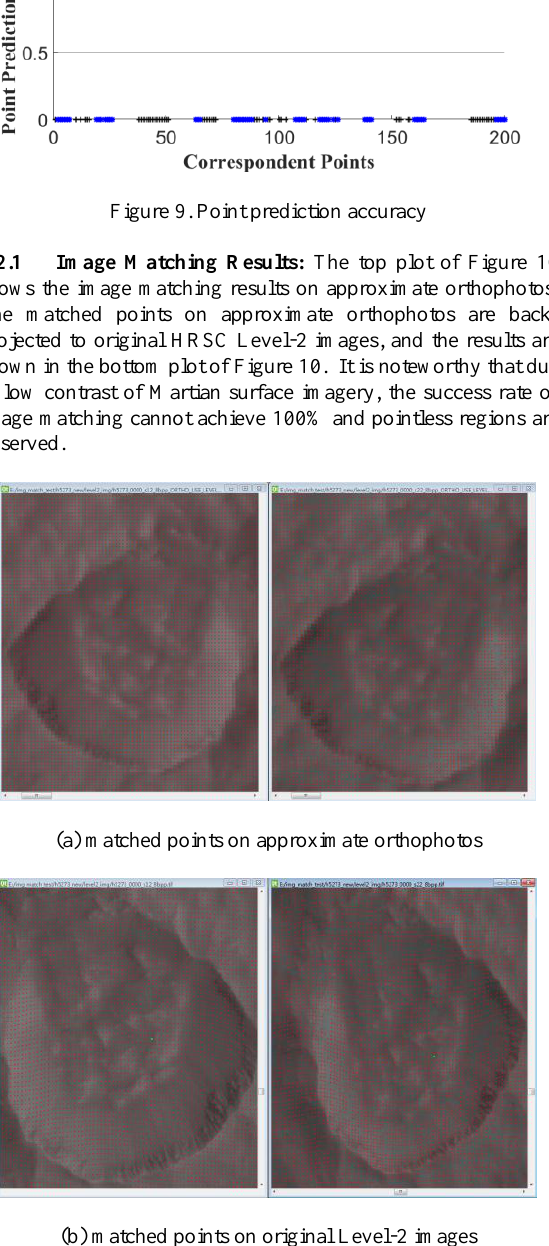
Figure 10. Image matching results on the third pyramid level (zoom in 4 times).